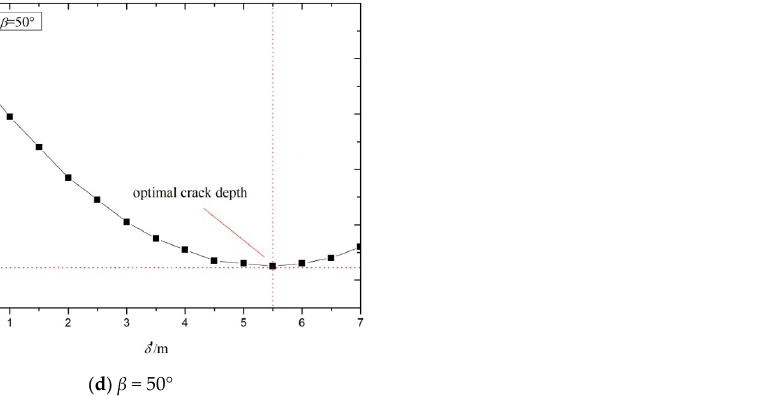
Figure 9. Relationship between safety factor and crack depth under different slope height.